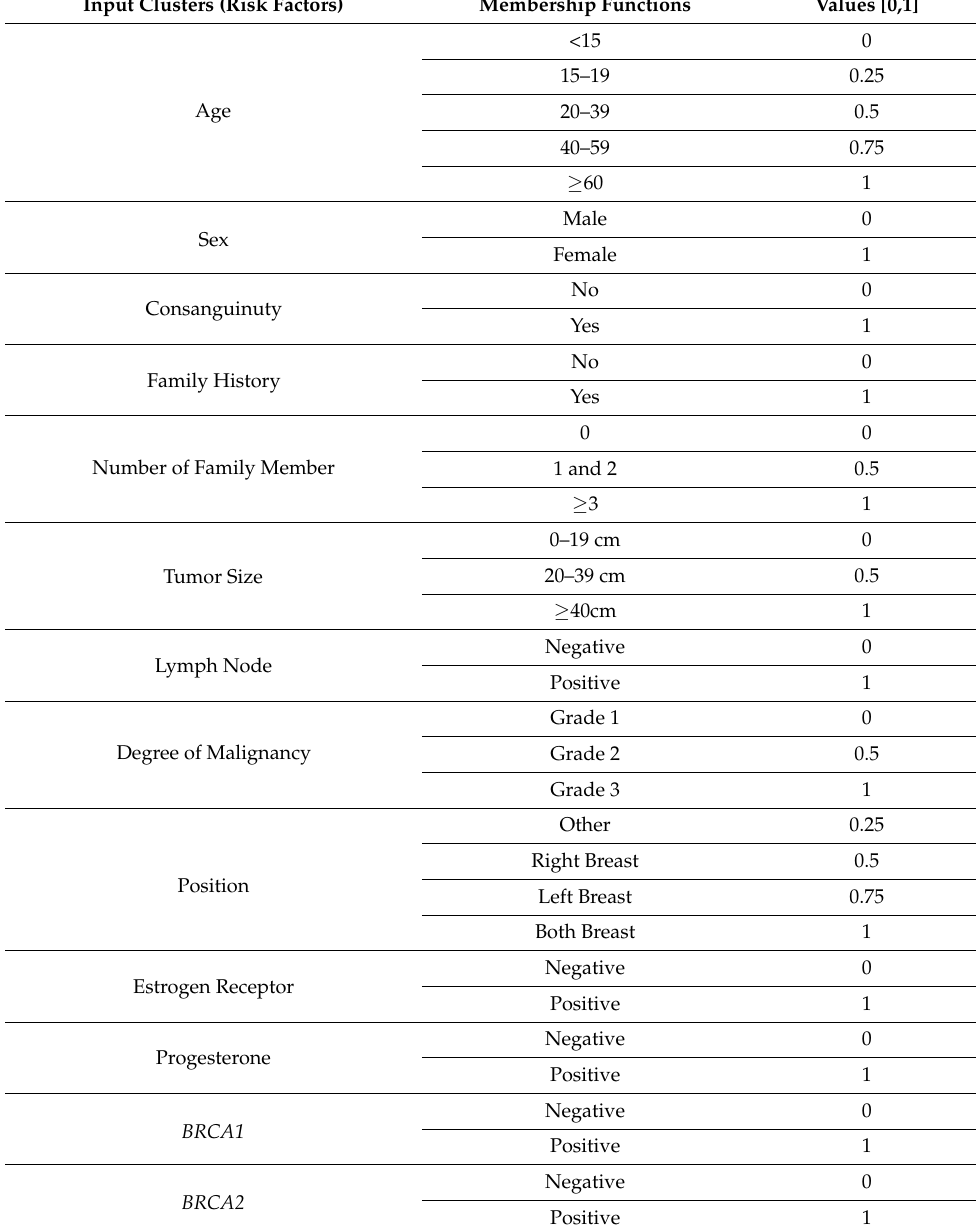
Table 1. Values of membership functions for each input cluster. * VUS: Variant of unknown